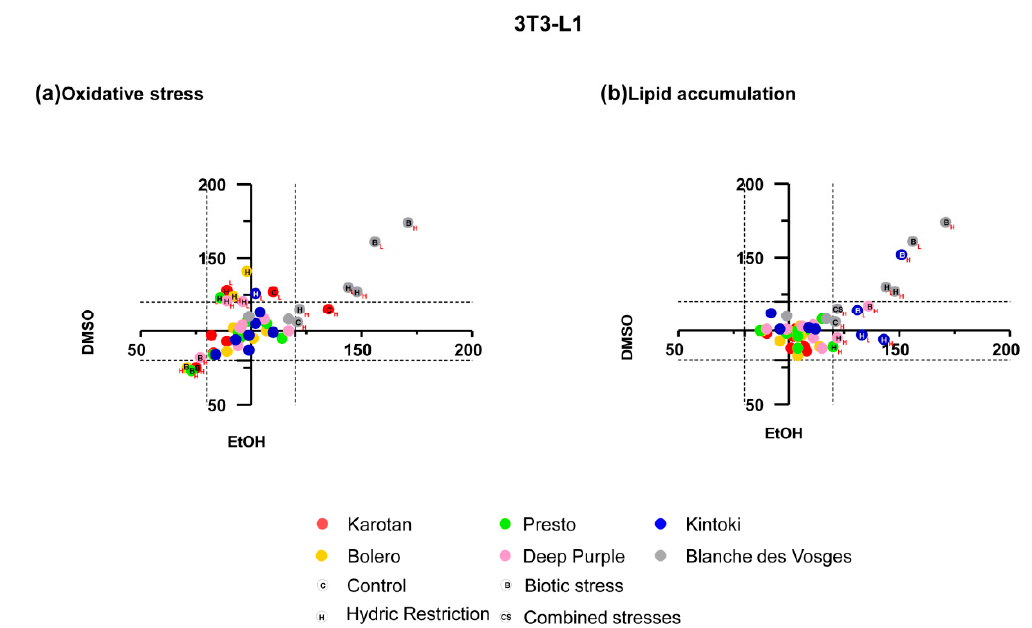
Figure A4. Effect of carrot extracts on adipocytes. Oxidative stress ( a ) and lipid accumulation ( b ) in 3T3-L1 after treatment with carrot extract from different carrot varieties and growing conditions. In each diagram, x-axis and y-axis express percentage response values of ethanol and DMSO extracts, respectively. Variations of less than 20% of responses (included in dot lines) were not considered biologically significant.